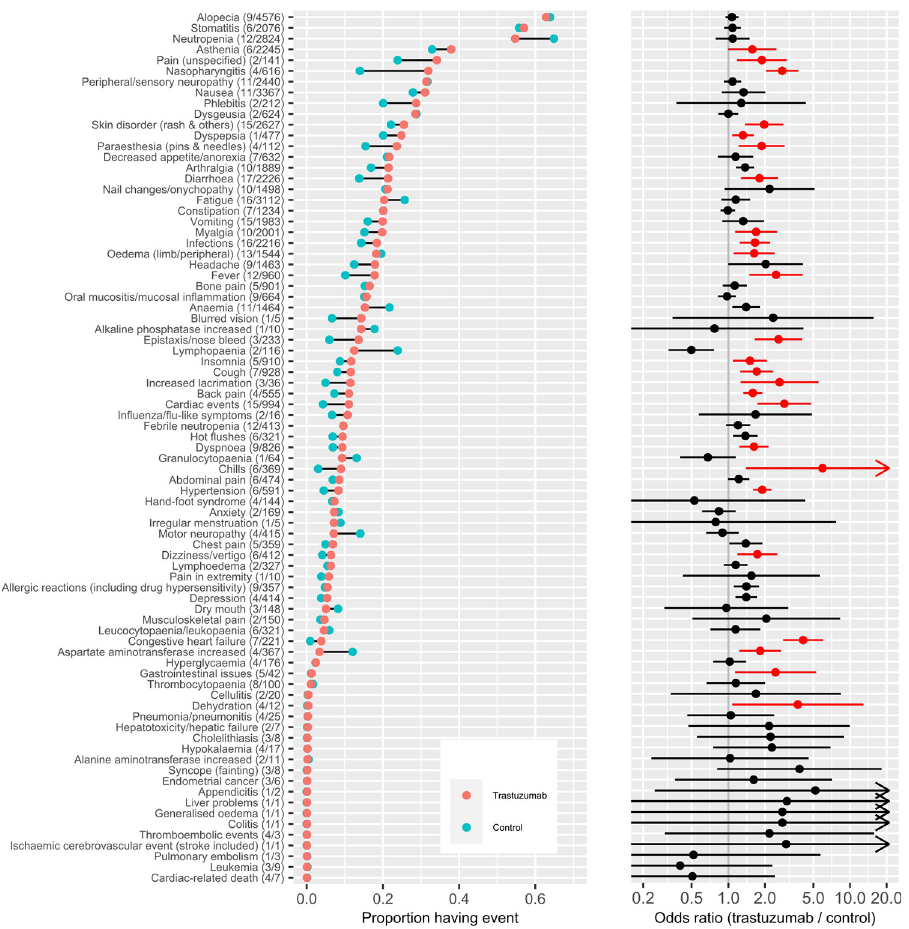
Fig 3. (left) Proportions of people in trastuzumab and control groups experiencing each adverse event, from pooled data from 23 trials. (right) Pooled odds ratio from random effects meta-analyses of each corresponding adverse effect of trastuzumab, with 95% confidence intervals (upper limit truncated at 20). Brackets after event name show (number of studies / overall number of observed events) contributing to each estimate.